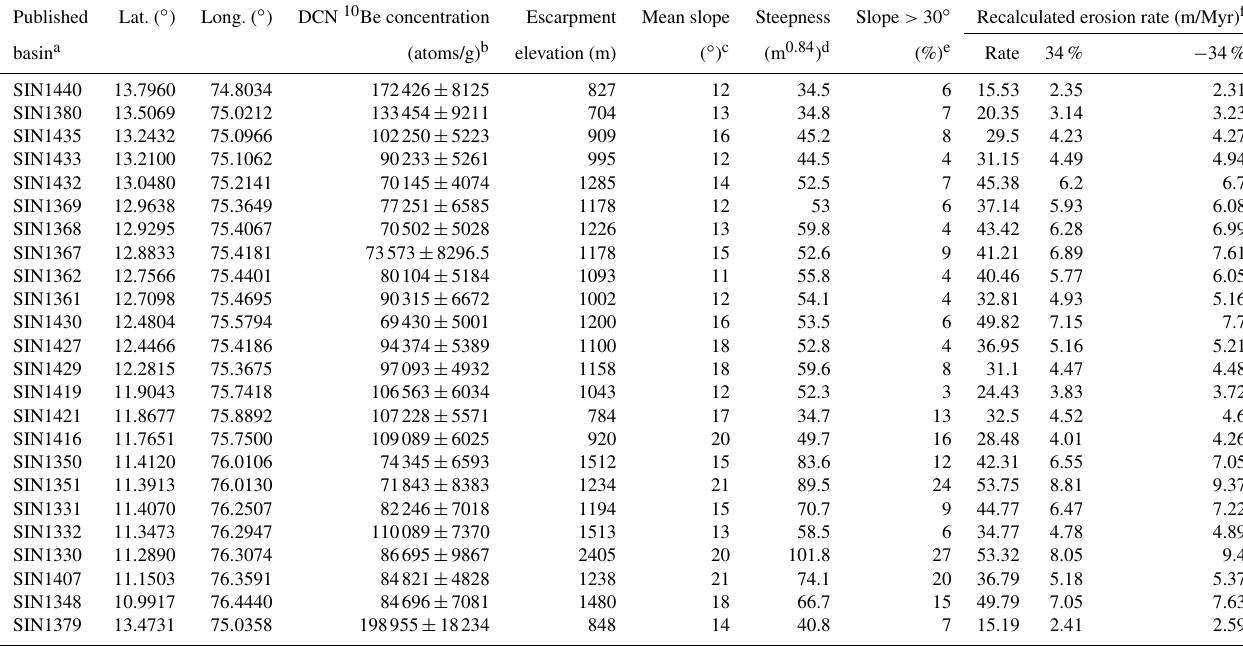
Table 1. Cosmogenic 10 Be basins of Western Ghats studied in this research. Published Lat. ( ◦ )